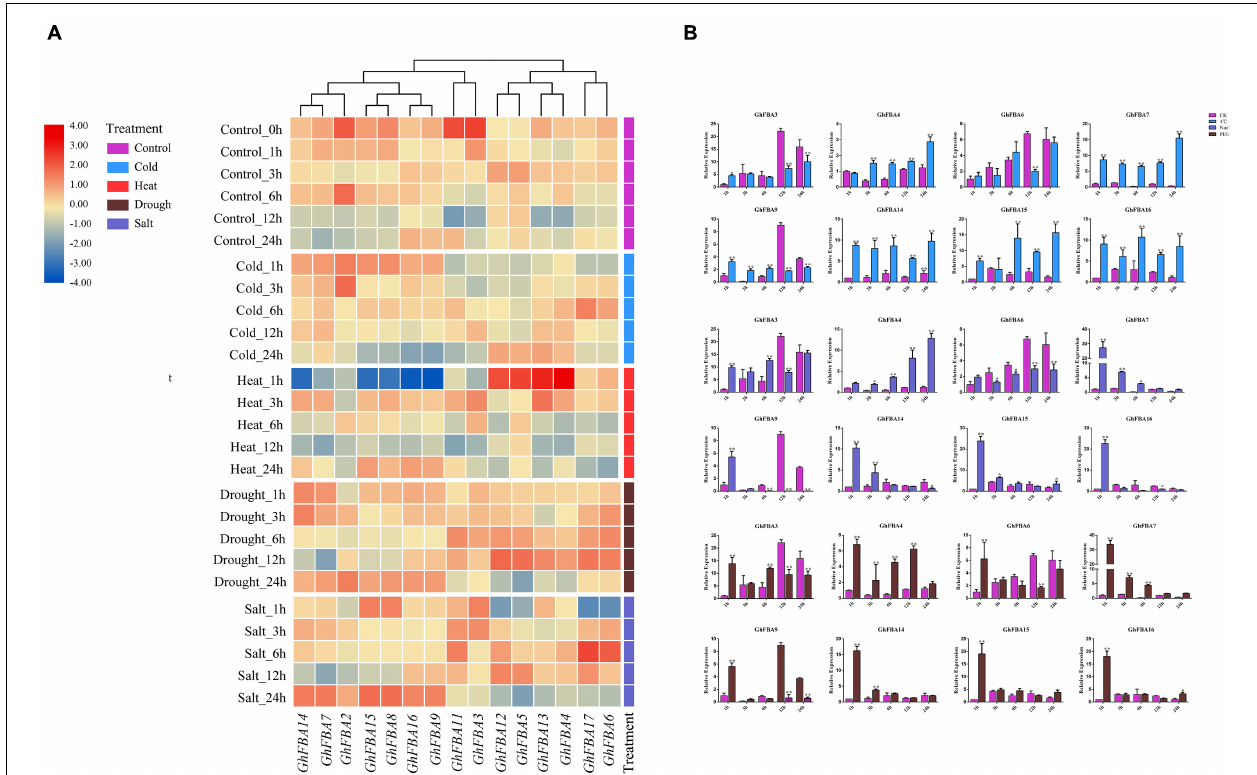
FIGURE 7 | Expression profiles of GhFBA genes under different stresses. (A) The log 2 (TPM + 1) values of TPM were used to create the heatmap, and z-score method was used to normalize the results by line. The transcript abundances were represented by color scales ranging from blue (low) to red (high). (B) Verification of the transcriptome data by qRT-PCR, GhHIS gene was used as reference gene, and asterisks indicate the significant differences between treatment groups and control groups (* P < 0.05, ** P < 0.01, Student’s t